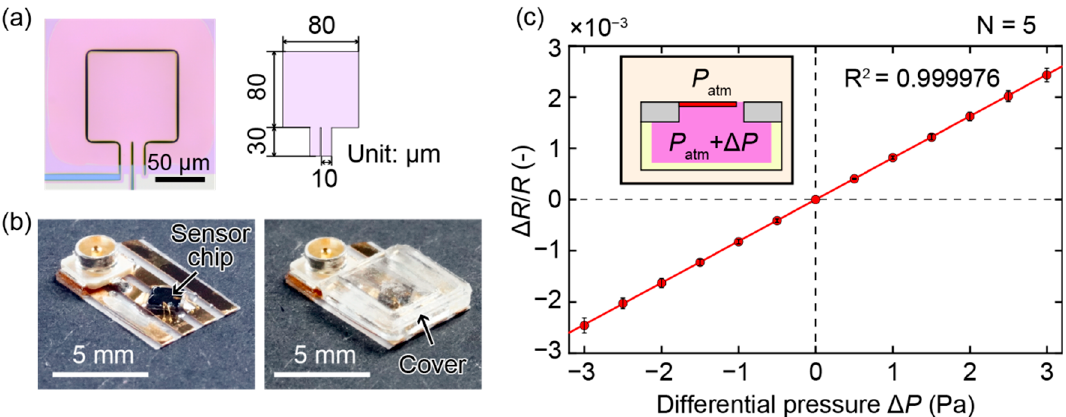
Figure 2. ( a ) Photograph of the fabricated cantilever and design parameters of the cantilever. ( b ) Photographs of the fabricated device with the sensor chip bonded to a printed electrode substrate. ( c ) Relationship between the applied differential pressure and the fractional resistance change of the cantilever.